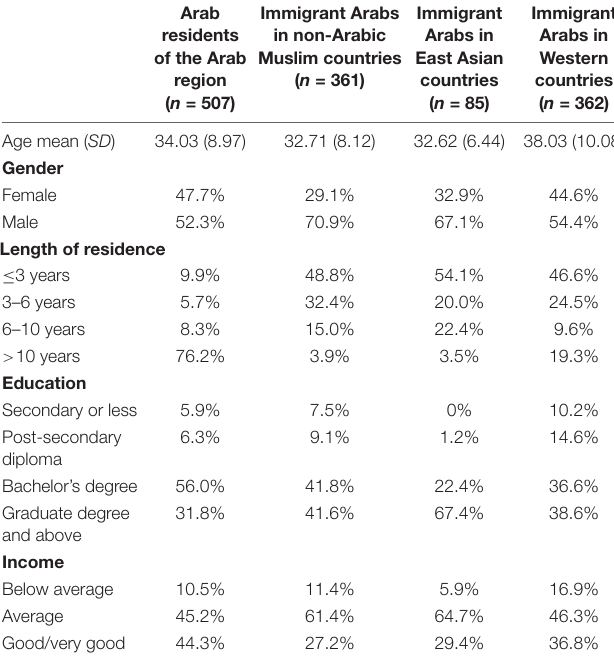
TABLE 1 | Socio-demographic characteristics of respondents by region of